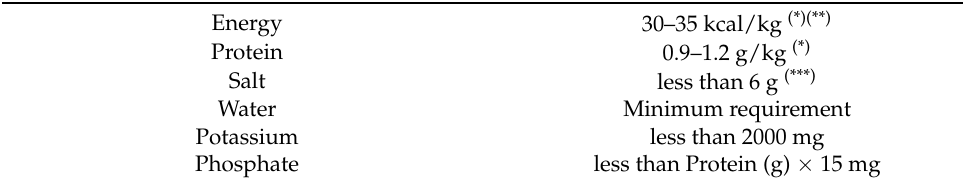
Table 1. Standard nutritional intake in hemodialysis patients in